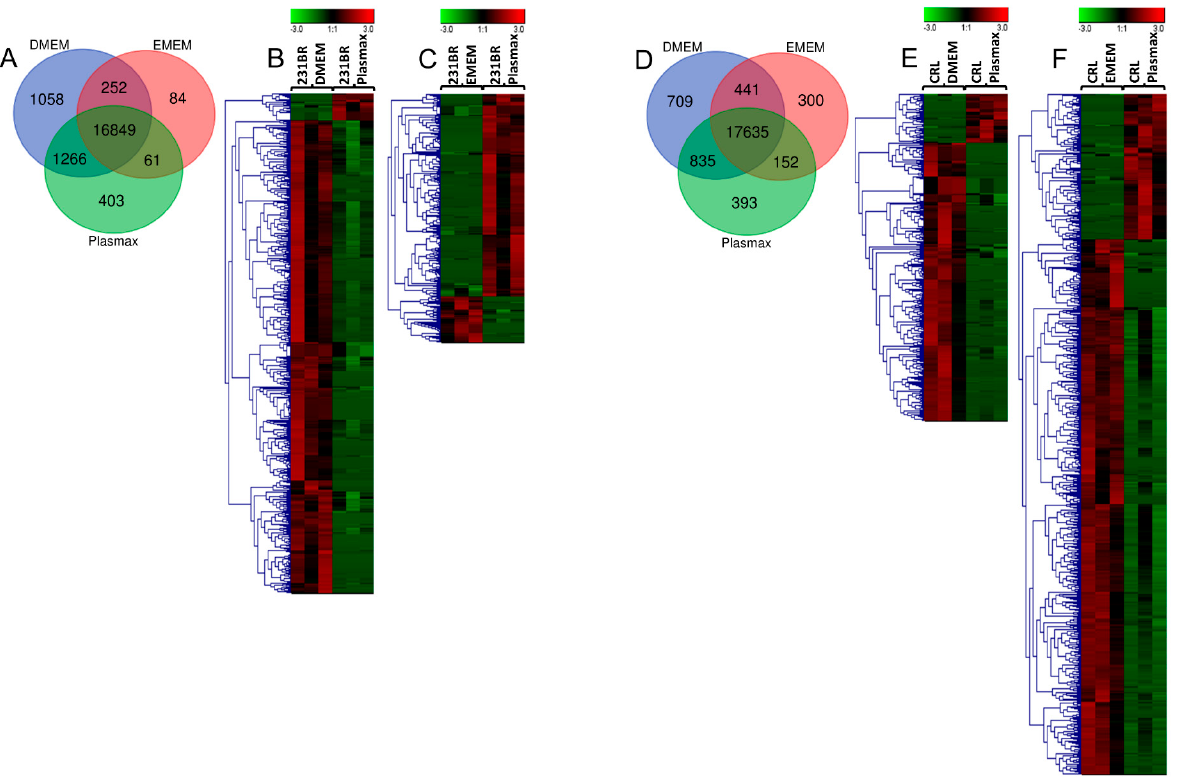
Figure 1. ( A ) Venn diagrams of transcriptome expressions in 231BR cell line cultivated by three media; ( B ) Heatmaps of significant transcriptomes from 231BR cell line cultivated in Plasmax and DMEM; ( C ) Significant transcriptomes from 231BR cell line cultivated in Plasmax vs. EMEM; ( D ) Venn diagrams of transcriptome expressions in CRL cell line cultivated by three media; ( E ) Significant transcriptomes from CRL cell line cultivated in Plasmax vs. DMEM; ( F ) Significant transcriptomes from CRL cell line cultivated in Plasmax vs. EMEM. The color codes denote expression level of genes. The green color denotes lower expression, while the red color denotes higher expression.